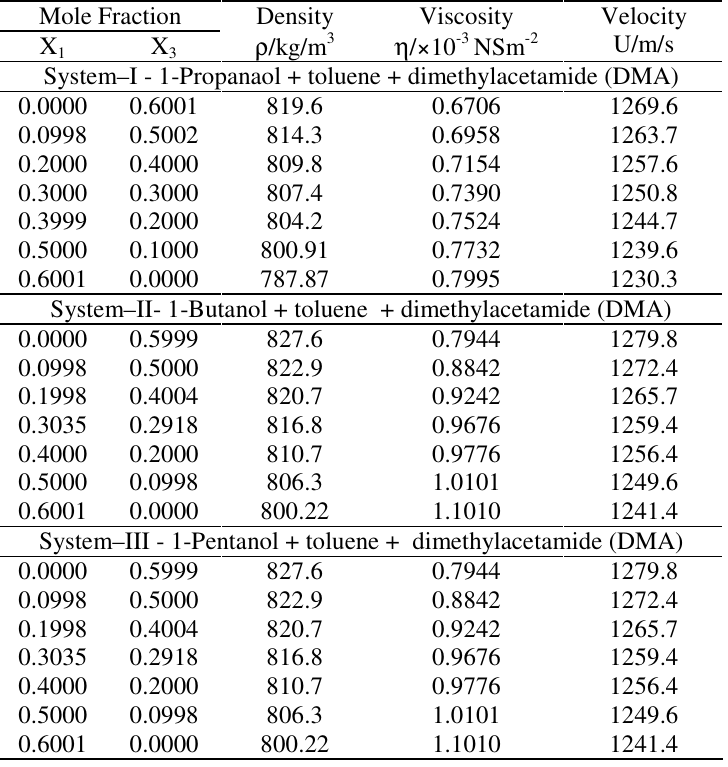
Table 2. Density ( ρ ), viscosity ( η ) and Ultrasonic velocity